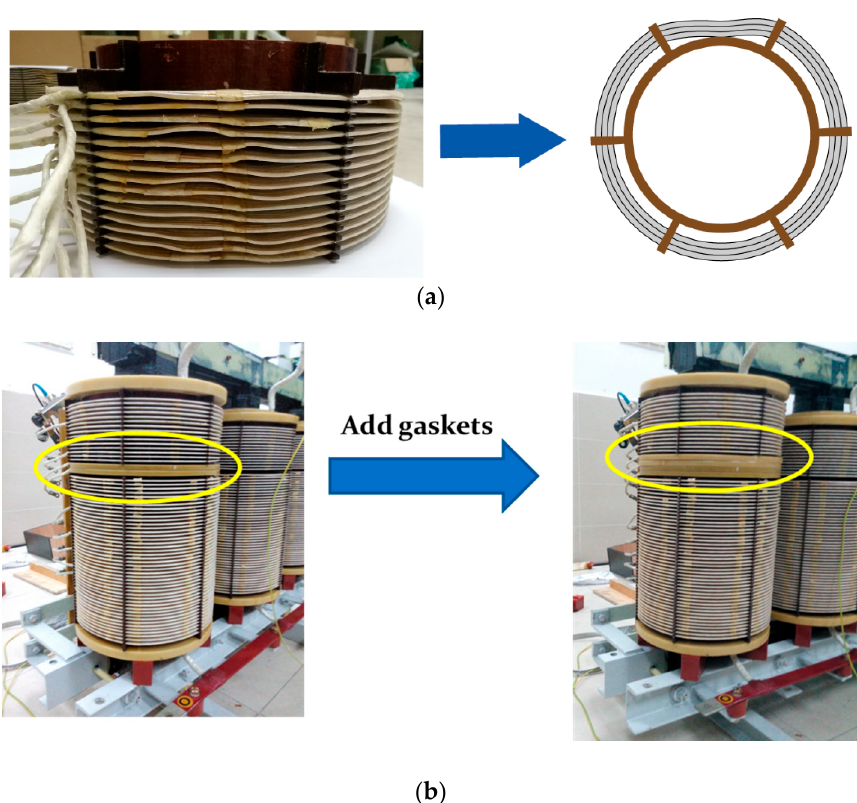
Figure 6. Schematic explanation of the experimental simulation of MD: ( a ) cases of radial buckling; ( b ) cases of axial displacement.